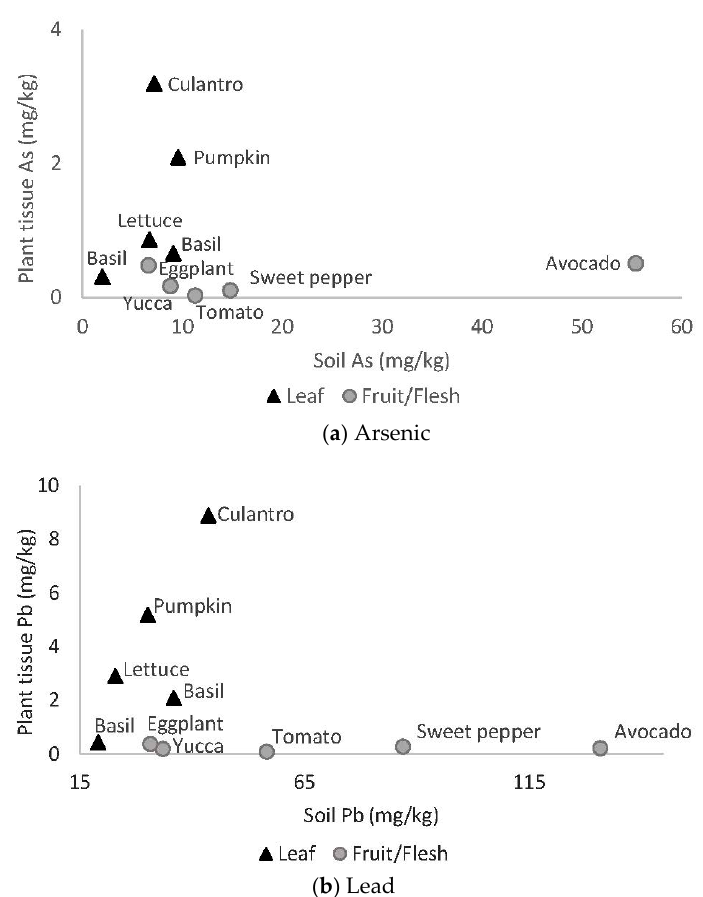
Figure 3. Relationship between soil As and Pb concentration and uptake in plant tissues categorized as leaf or flesh. Table 2. Paired plant and soil As and Pb concentrations with associated TFs. Plant concentrations reported on a dry weight